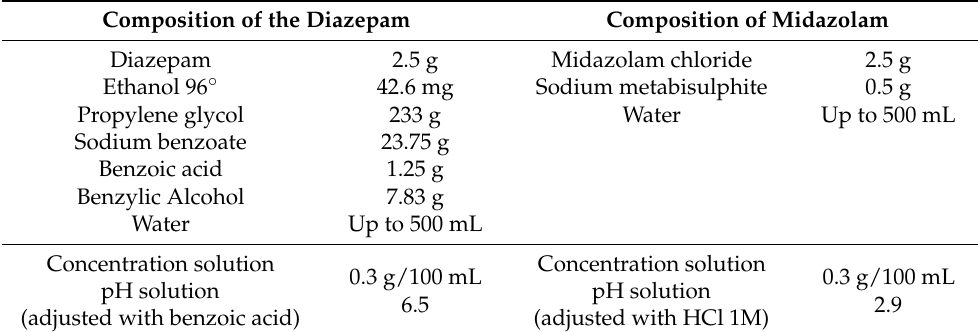
Table 2. Composition of the diazepam and midazolam parenteral